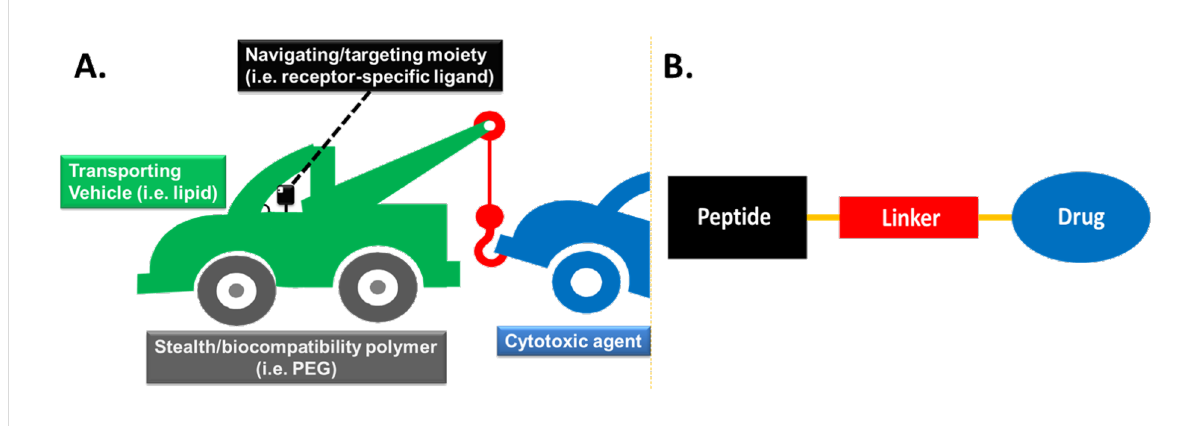
Figure 2: A. General structural architecture of the ideal navigated drug delivery system [31]. B. General structure of a peptide–drug conjugate (PDC).